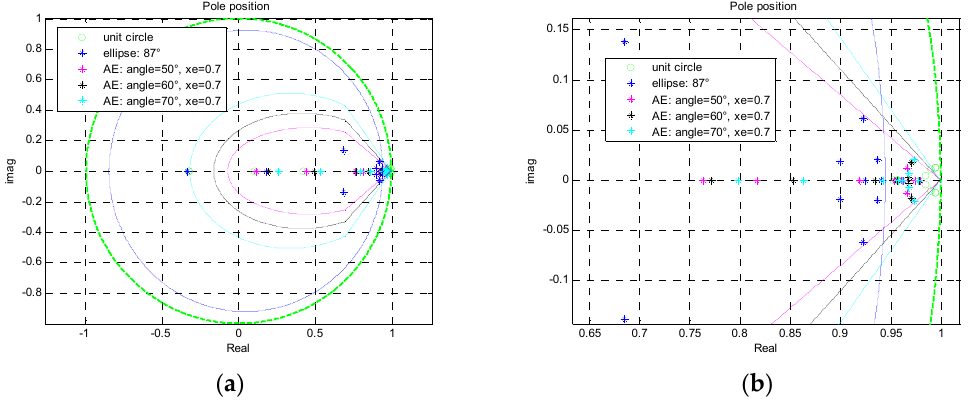
Figure 10. Prescribed pole regions and corresponding closed loop poles for tested variants: ( a ) The overall regions and ( b ) the detail on pole location near the right-hand side border of D R regions. Algorithms 2019 , 12 , x FOR PEER REVIEW